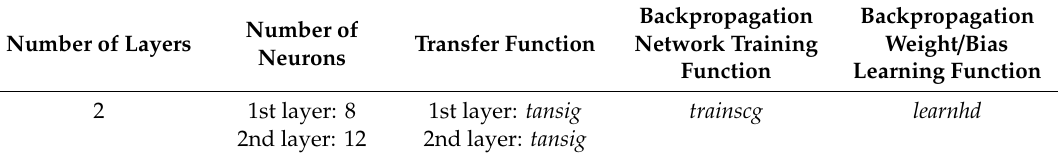
Table 1. Hyperparameters of the multilayer perceptron ANN used in the Artificial Neural Network–Particle Swarm Optimization (ANN–PSO)